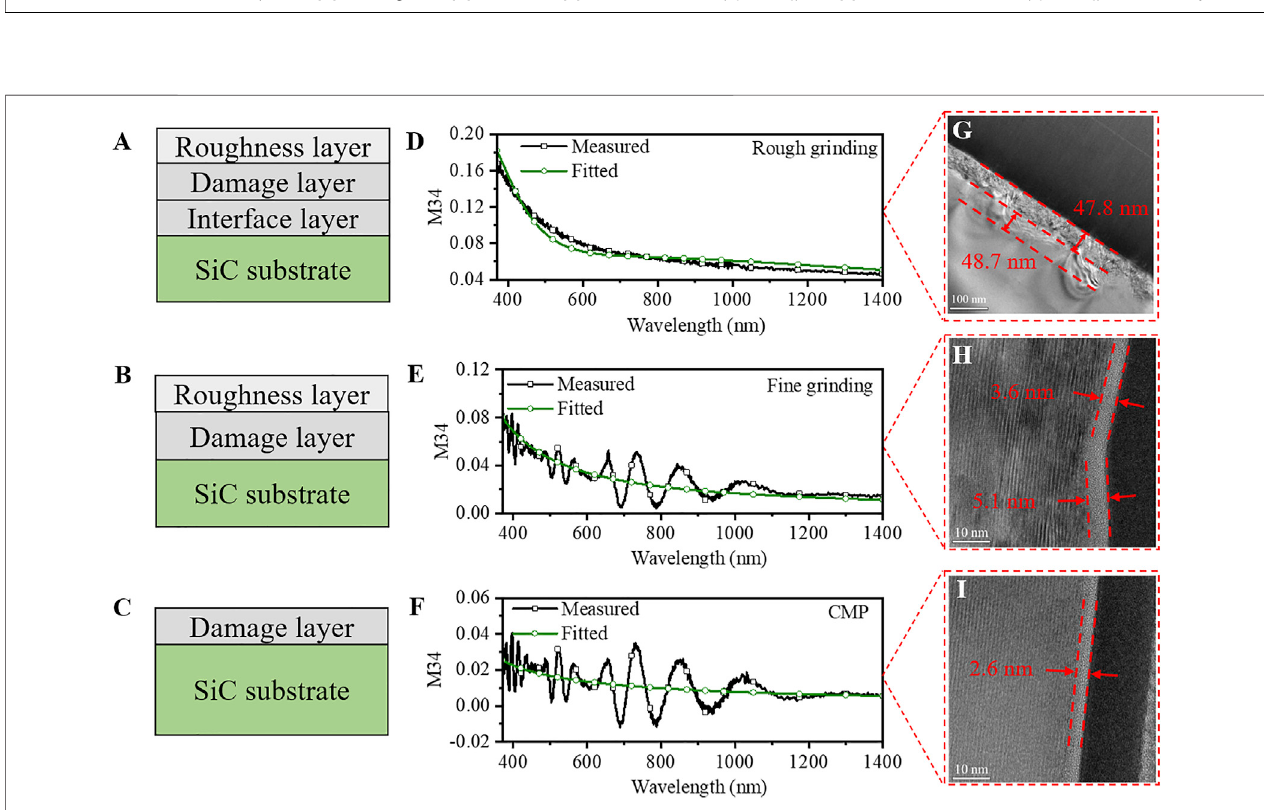
FIGURE 7 | (A – C) are the schematic diagrams of optical stack models. (D – F) are fi tting results of M34. (G – I) are the typical TEM images of rough grinding, fi ne grinding, and CMP 4H-SiC wafers.